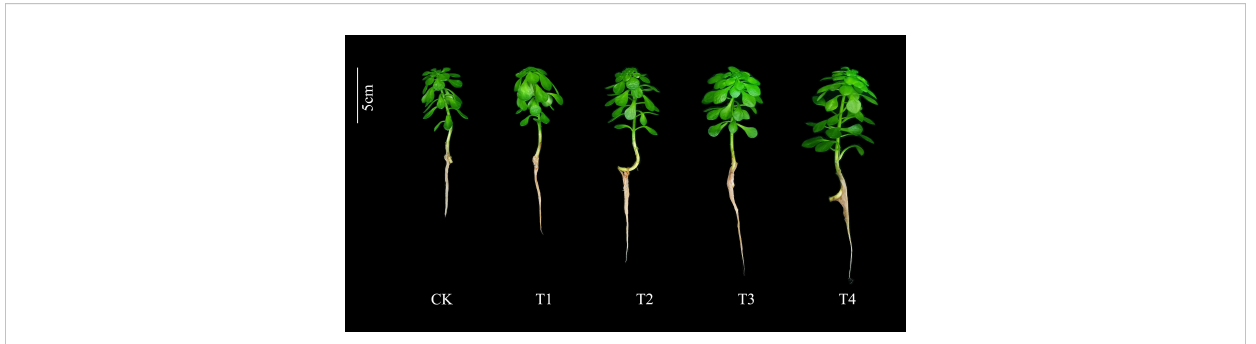
FIGURE 1 Effects of different Si treatments on the growth of S. alfredii . CK: control treatment, T1, T2, T3 and T4 were the Si concentrations of 0.5, 1.0, 1.5 and 2.0 mmol ∙ L -1 , respectively.